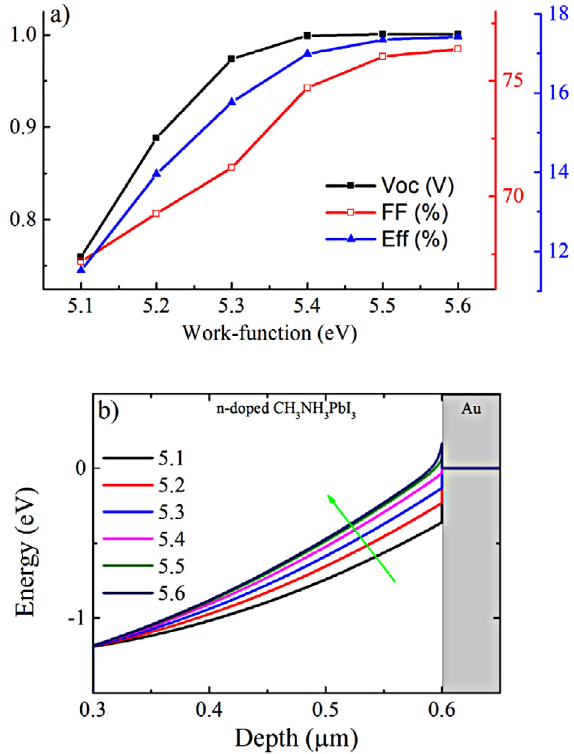
Fig. 7. (a) Open circuit voltage ( V OC ), fill factor (FF) and efficiency (Eff) of HTM-free CH 3 NH 3 PbI 3 PSC as a function of the work-function (WF) of hole collector conductor. (b) Va- lence band variation as a function of